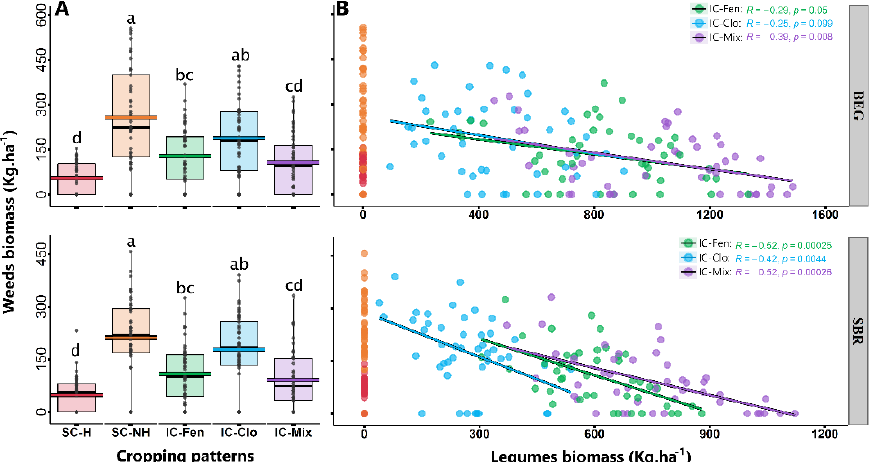
Figure 3. Effect of cropping patterns on weed biomass, averaged over the three seasons and the five N treatments ( A ) and the relationship between weed biomass and legume biomass in each intercropping pattern ( B ) at both sites.( A ): Box plot indicating the cropping pattern effects on the weed biomass averaged over the three seasons and the five N treatments (Colored lines indicate the mean); Box plots with a common letter are not significantly different at p < 0.05 according to Tukey’s HSD-test.( B ): Relationship between weeds biomass and legumes biomass in each intercropping pattern (R-values are the correlation coefficient (Spearman’s correlation); colored lines represent linear regression for each intercropping pattern).